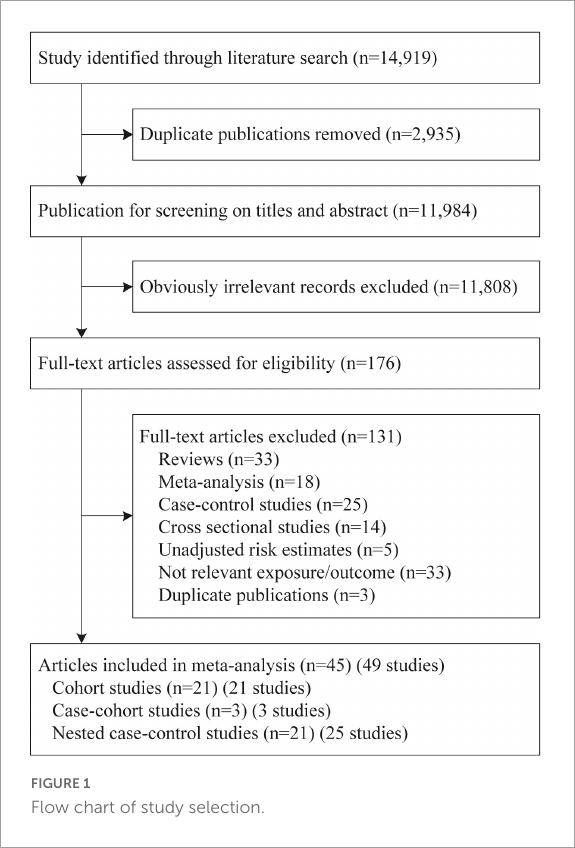
FIGURE1 Flow chart of study